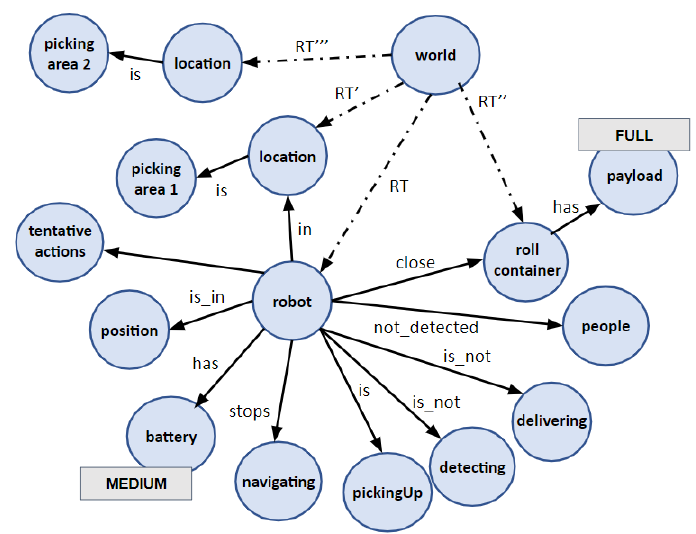
Figure 1. Unified representation as a multi-labelled directed graph. For instance, edges labelled as close or is_not denote logic predicates between nodes. On the other hand, edges starting at world and ending at robot and roll container are geometric and they encode a rigid transformation ( RT and RT (cid:48)(cid:48) respectively) between them. Geometric transformations can be chained or inverted to compute changes in coordinate systems (see